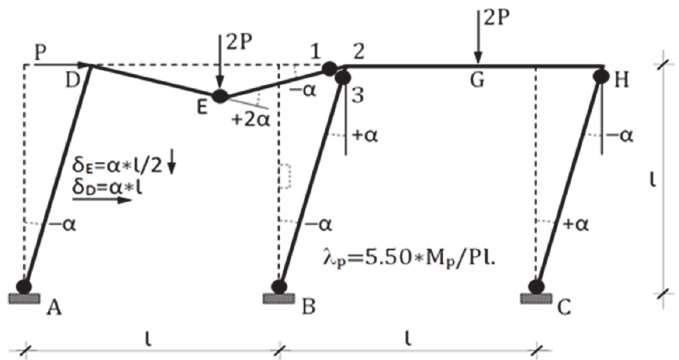
Figure 4: Scheme with an imprinted articulated